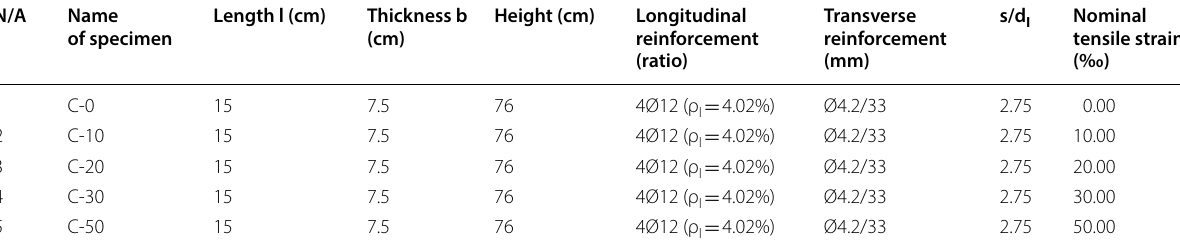
Table 1 Geometrical and detail properties of element specimens.